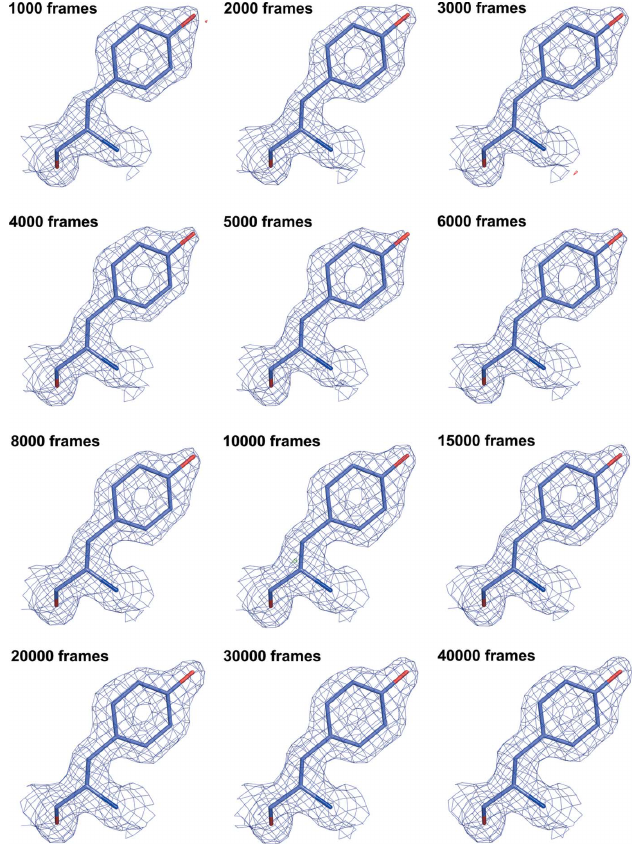
Figure 5 (cid:5) -weighted 2 F o (cid:2) F c electron density around Tyr41 of NhGH11 xylanase for models refined against the datasets made using the stated number of frames. Resolution cut-off for all datasets was 1.9 A˚ and all maps are displayed at 1 (cid:5)